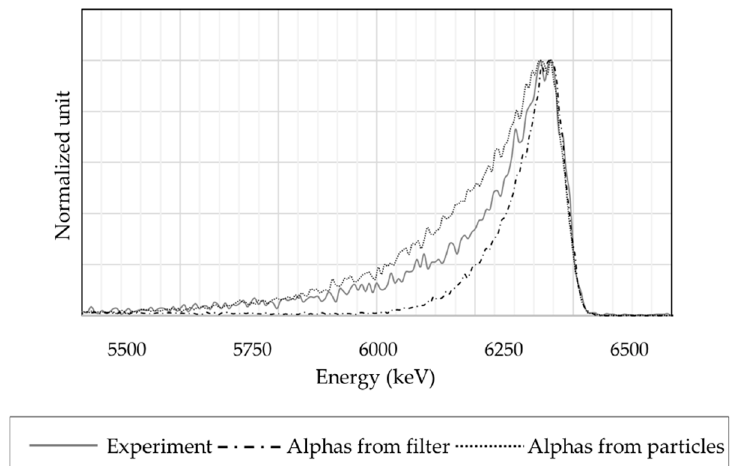
Figure 9. Comparison between an experimental spectrum and two simulated spectra, centred on the 214 Po alpha peak. The alpha-radiation source in the two simulations differs: one comes from the filter, while the other from the coarse